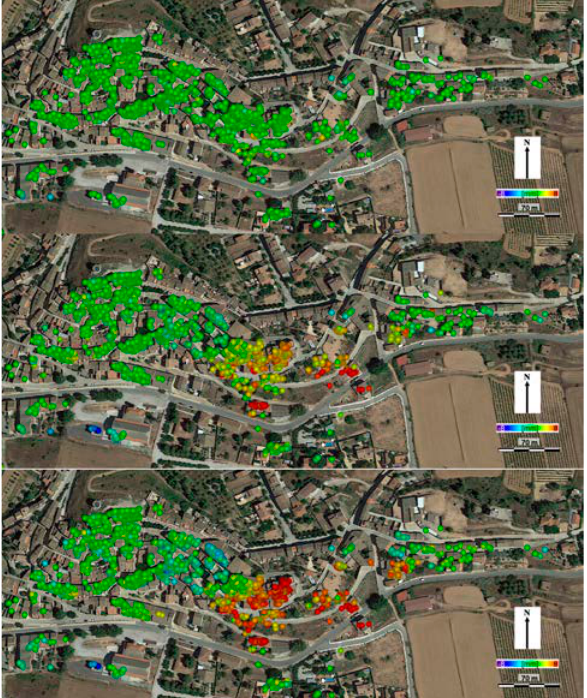
Figure 2. Displacement maps of Barberà de la Conca (Spain) between November 2011 and December 2011 (above), between November 20111 and May 2012 (middle) and between November 2011 and March 2013